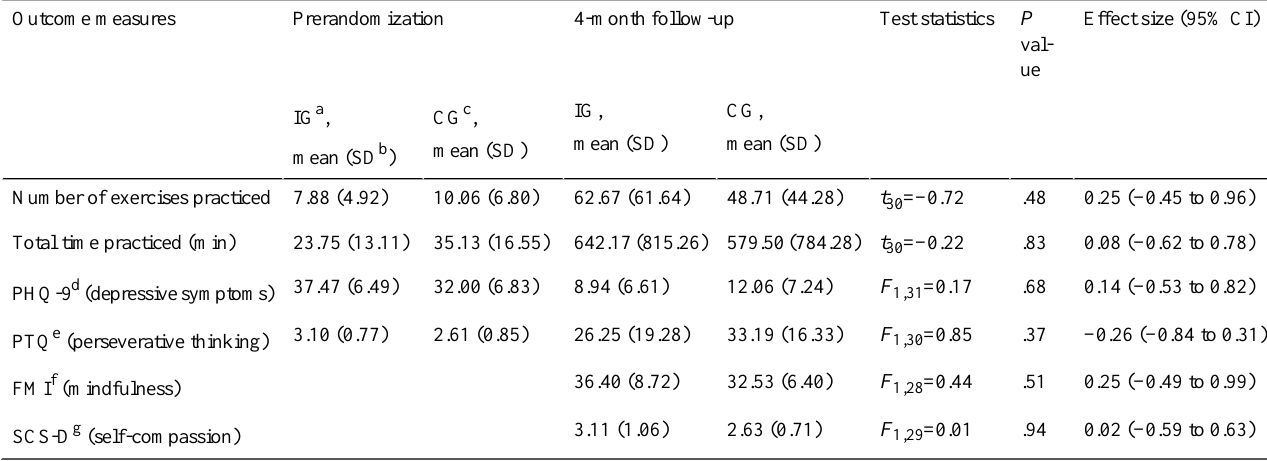
Table 2. Effect of the intervention on mindfulness practice and outcomes